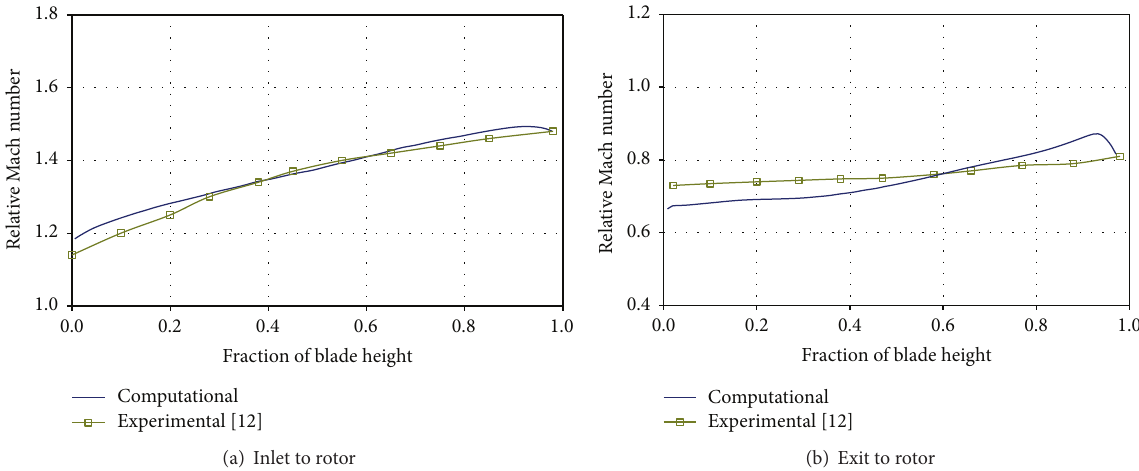
Figure 9: Radial variation of relative Mach number at inlet and exit to the baseline rotor at 100% design rotational speed and comparison with experimental data of [12].